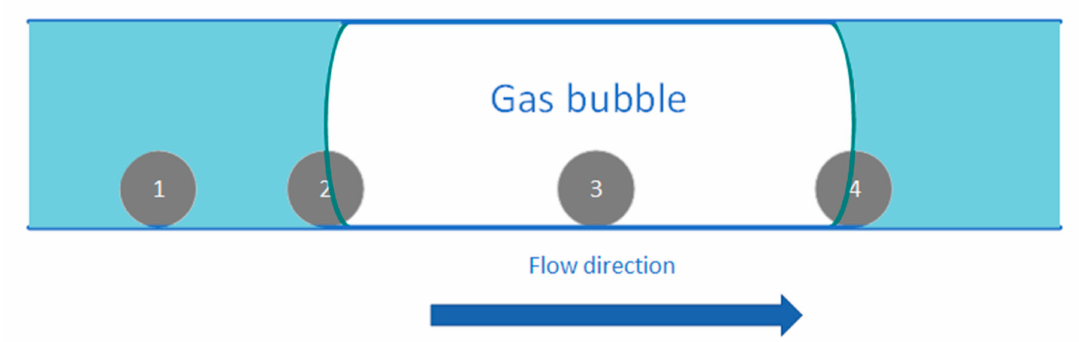
Figure 1. Four states of particles in non-Newtonian